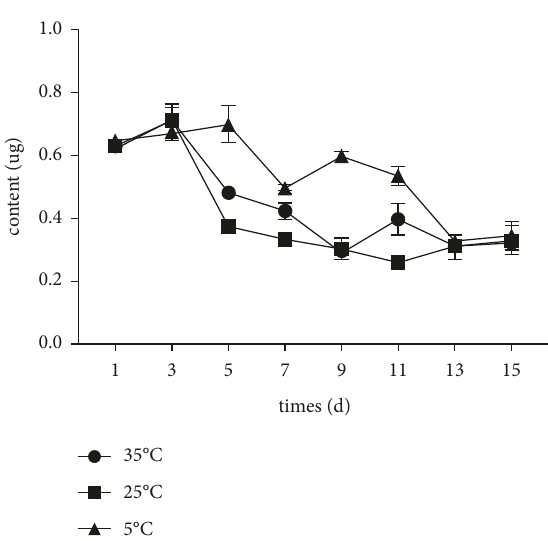
Figure 8: Changes in flavonoid content at different